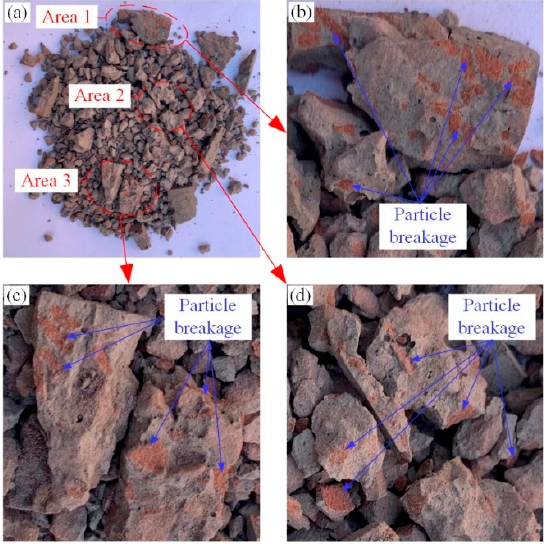
Figure 14. Breakage behavior of rock particles: ( a ) broken sample after dynamic impact; ( b ) area 1; ( c ) area 2; ( d ) area 3.